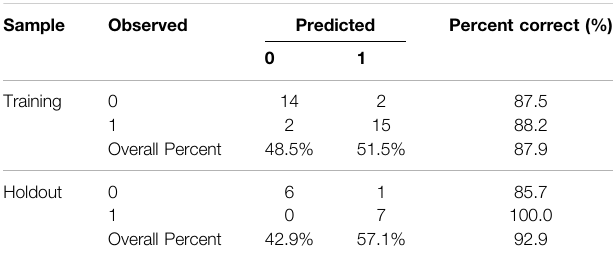
TABLE 1 | The classi fi cation table of the practical results.